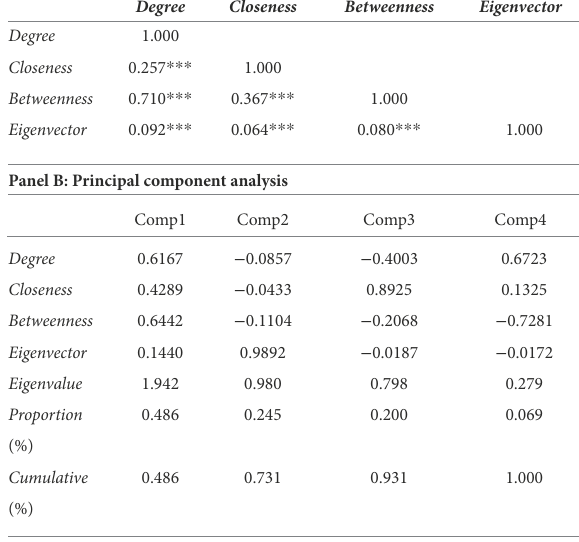
TABLE 2 Correlation analysis between centrality indicators. Panel A: Correlation analysis of the four centrality